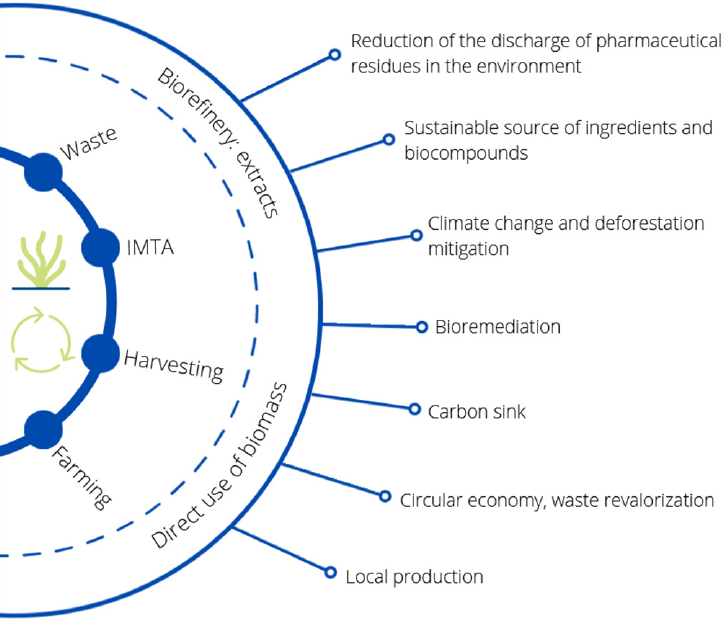
Figure 4. Environmental benefits of revalorizing seaweeds for animal feed.